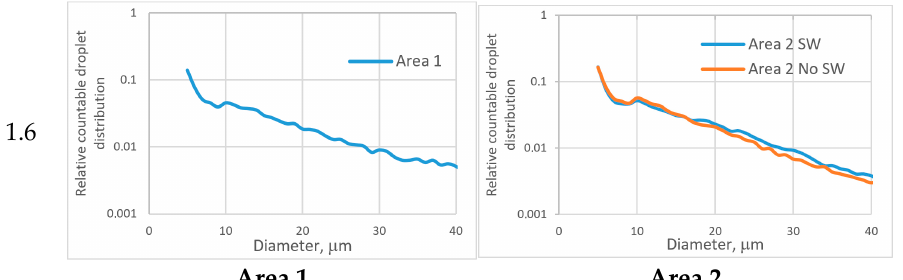
Figure A2. Relative countable droplet distribution by diameters, gas flow Mach number M = 2.5. The left column shown water injection pressure p l , MPa.